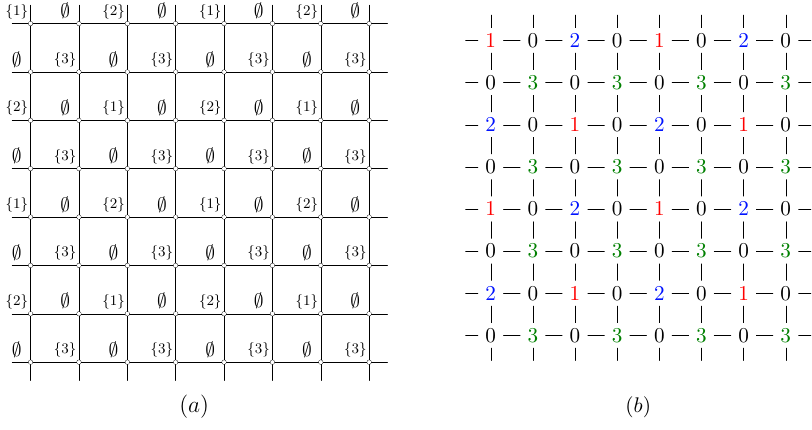
Figure 2. A 3RDF on C 8 2 C 8 . (a) vertex labelled with color sets. (b) vertex labelled with codes.